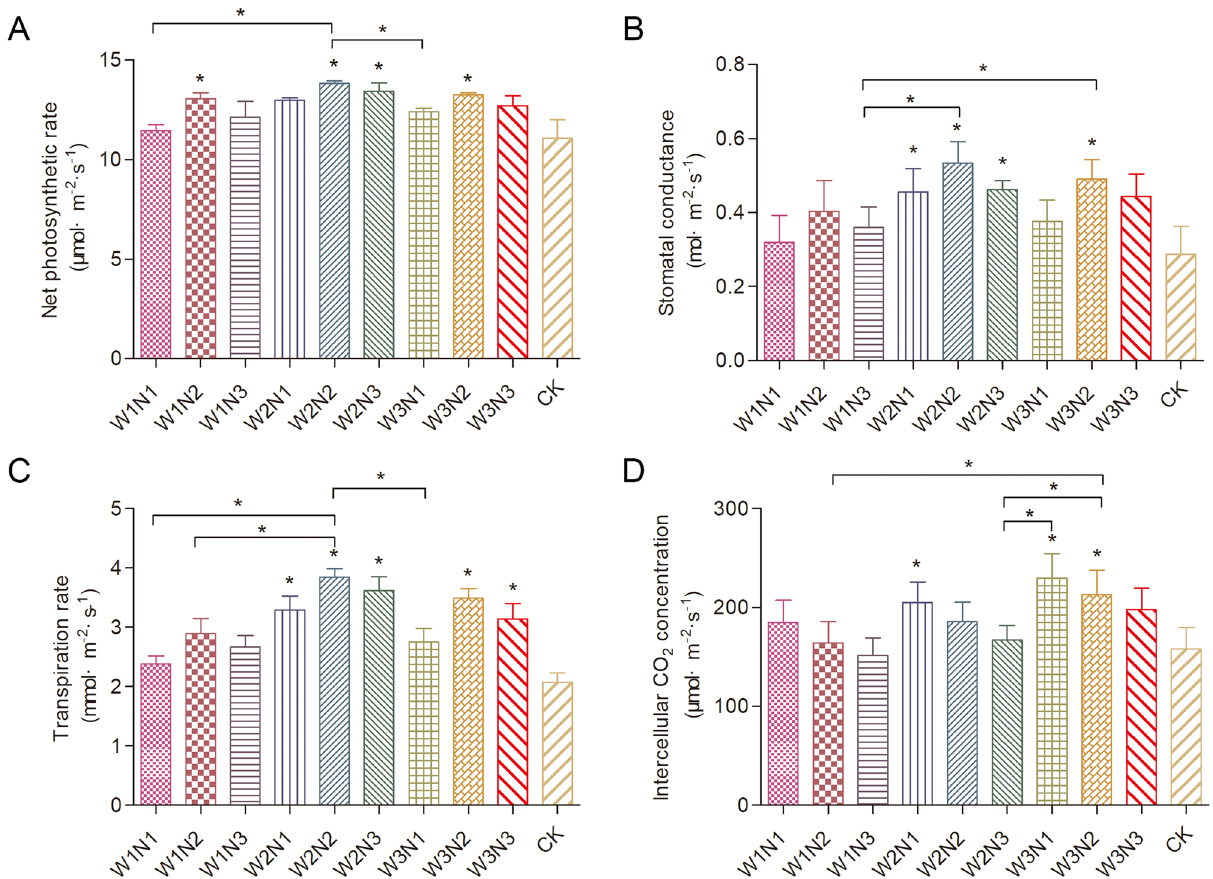
Figure 1. Photosynthetic characteristic values for Isatis indigotica in all treatments. The values shown are the mean ± SD, n = 3. Asterisks (*) indicate a significant difference at the P ≤ 0.05